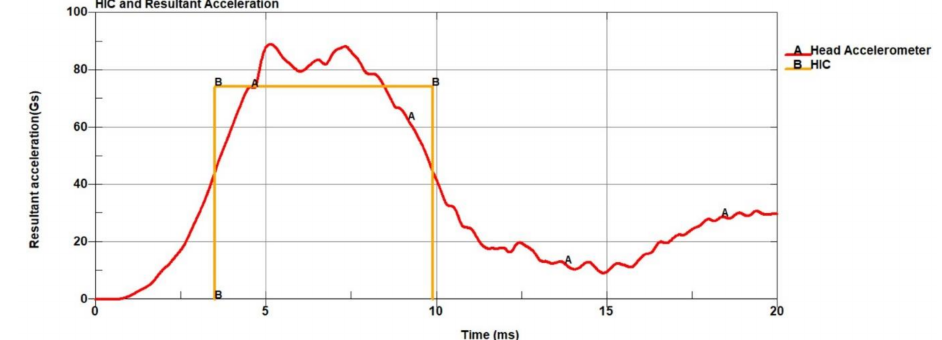
Figure A19. The course of simulation (0–20 ms, 5 ms interval) in configuration UT.